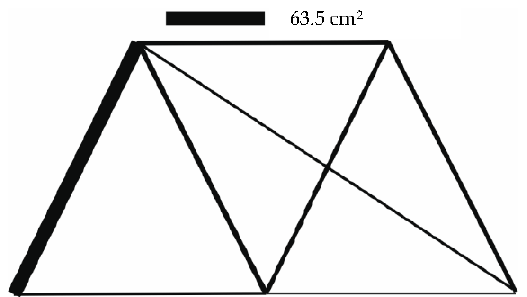
Figure 13. Initial 15 bar structure optimized for load case 3.